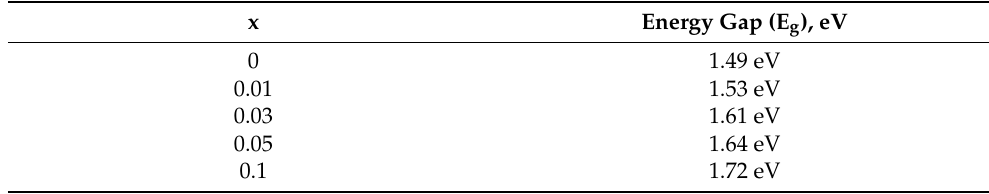
Table 1. The experimental values of E g for Cd 1 − x Be x Te.